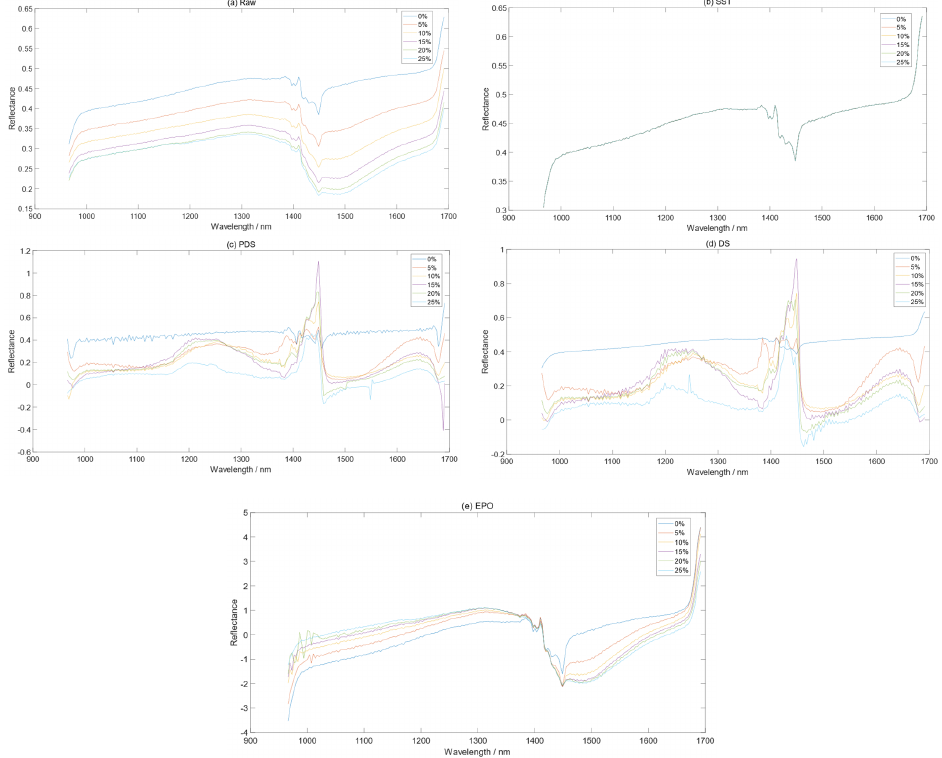
Figure 5. Average spectral curves of soil samples with 0% (dry soil), 5%, 10%, 15%, 20%, and 25% moisture content: ( a ) before spectral correction, ( b ) after SST correction, ( c ) after PDS correction, ( d ) after DS correction, ( e ) after EPO correction.